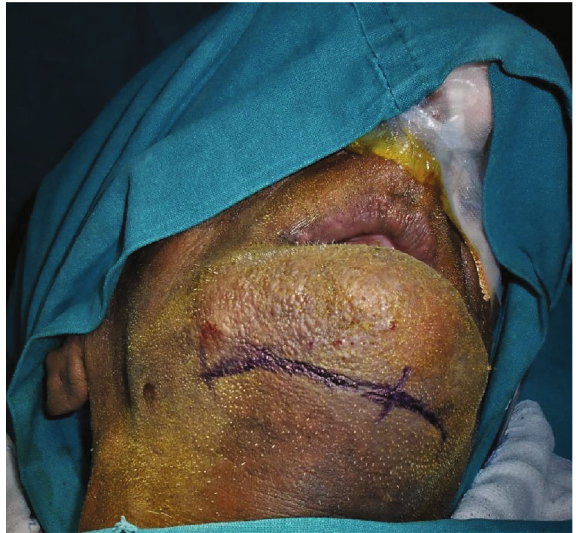
Figure 9: PA view of the mandible taken at the same time.